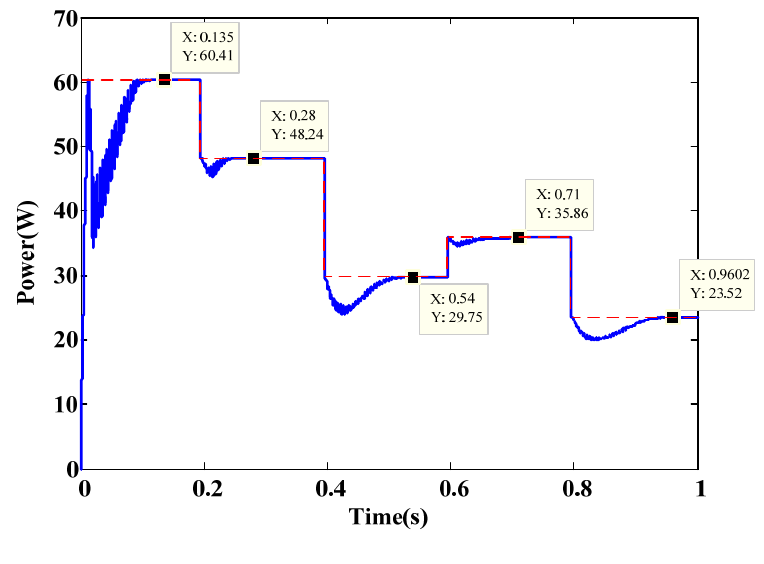
Figure 26. Simulation results for Algorithm